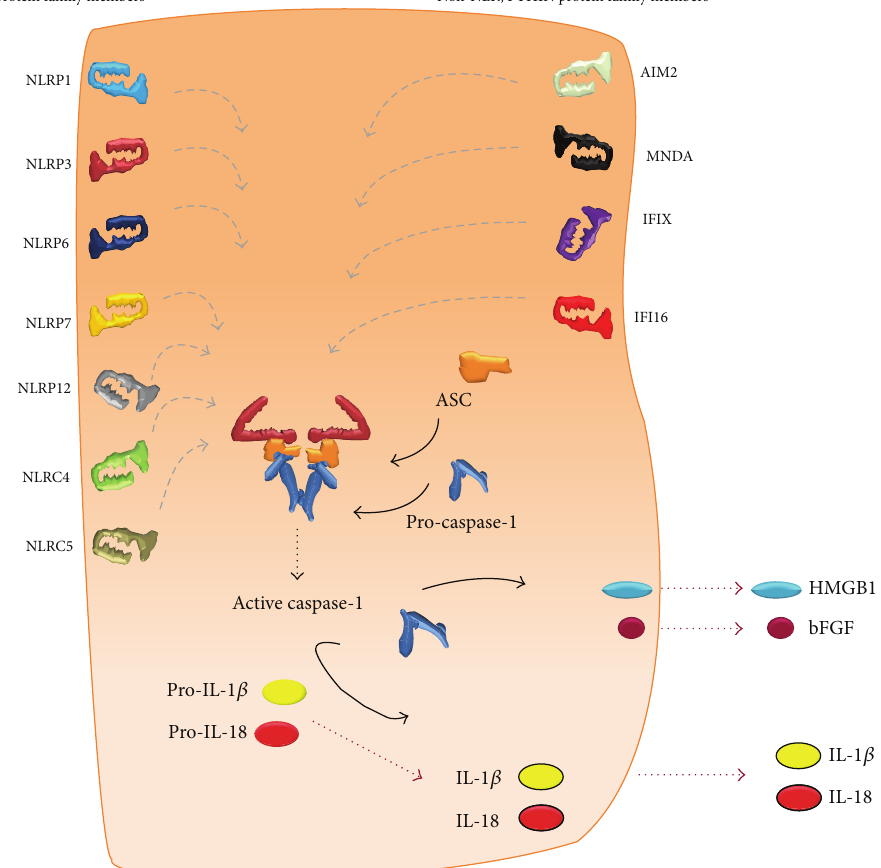
Figure 1: Schematic representation of all intracellular nucleotide-binding oligomerization domain receptors, in short NOD-like receptor (NLR), and pyrin and HIN200 domain-containing (PYHIN) inflammasome members, which are each able to assemble with the protease caspase-1 via the adaptor molecule apoptosis-associated speck-like protein containing a CARD (ASC) when triggered. This allows the activated enzyme to cleave and mature proinflammatory cytokines, interleukin- (IL-) 1 𝛽 , and IL-18 as well as inducing the unconventional release of basic fibroblast growth factor (bFGF) and high-mobility group box 1